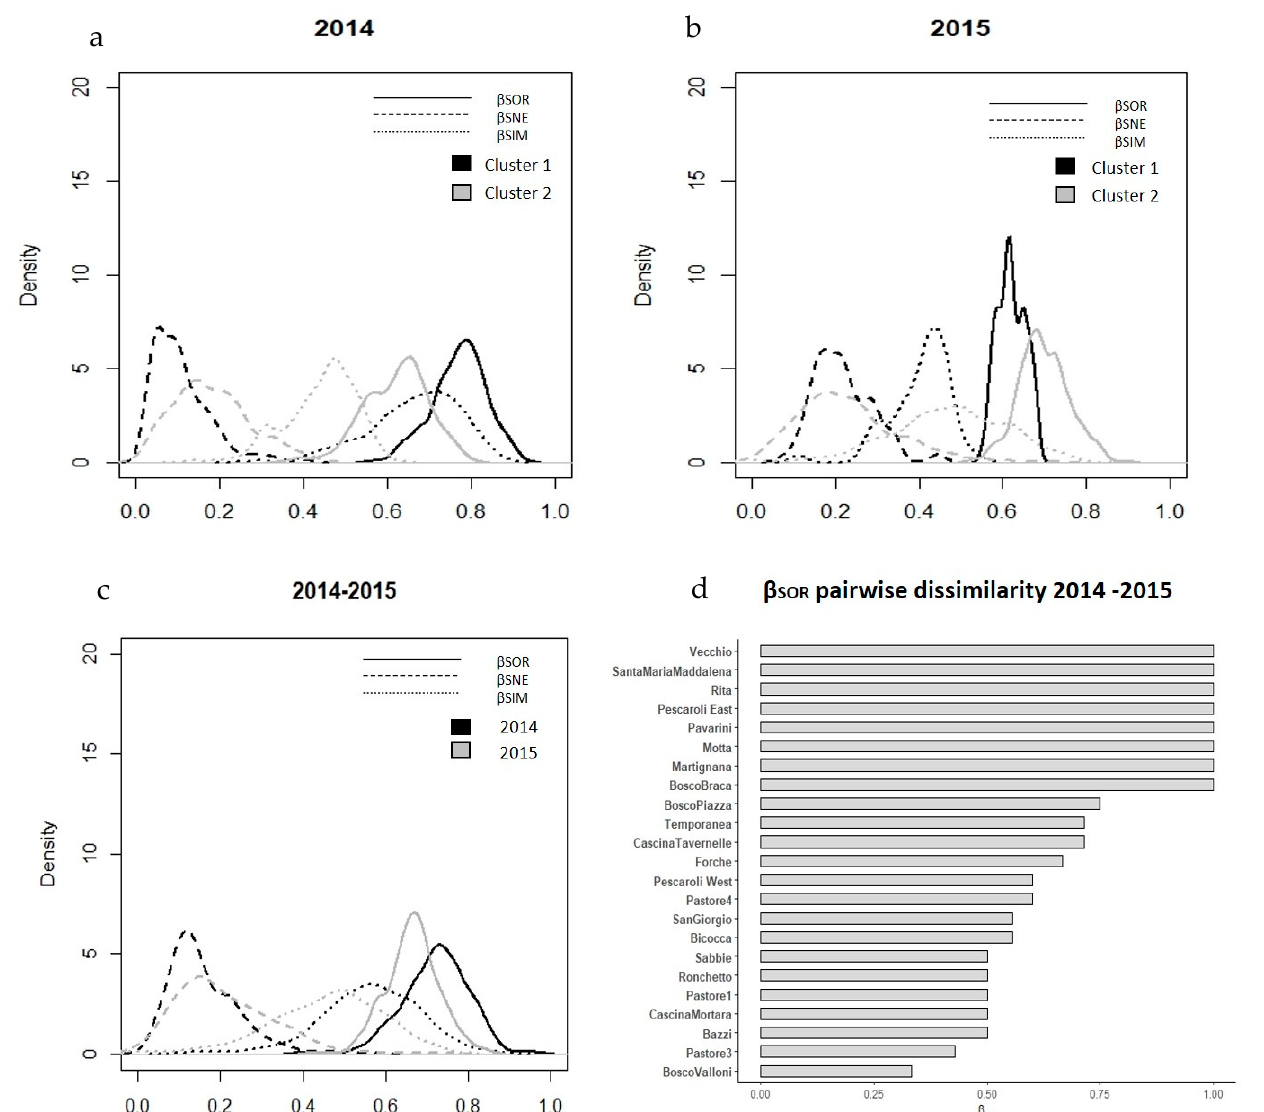
Figure 4. The panels ( a , b ) report the distributions of the beta diversity index ( β SOR, continuous line), beta nestedness ( β SNE, coarse dashed line) and beta turnover ( β SIM, tiny dashed line) for the two clusters and for the two years of study. The distributions were estimated with a boostrapping procedure (n = 500). The panel ( c ) reports the overall distribution of beta diversity and the relative component, nestedness and turnover in 2014–2015. The panel ( d ) reports the histograms of the pairwise beta diversity ( β SOR) between the same pond in two different years.